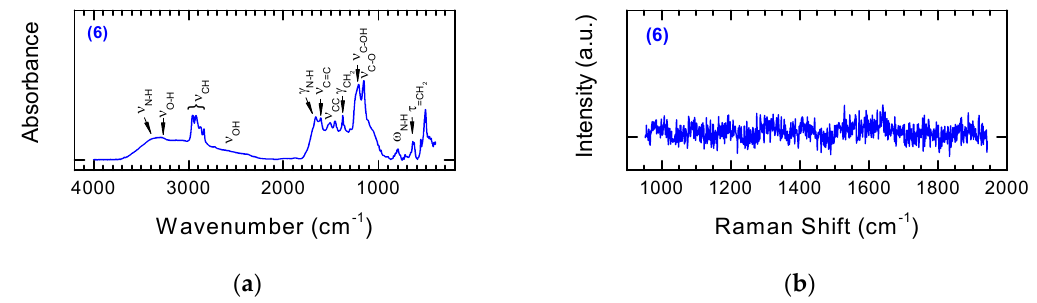
Figure 12. FT-IR ( a ) and Raman spectra ( b ) of NDPs 6 modified with 5(6)-carboxyfluorescein derivative FL-CONH-(CH 2 ) 2 -NH 2 and folic acid derivative FA-CONH-(CH 2 ) 5 -COOH.